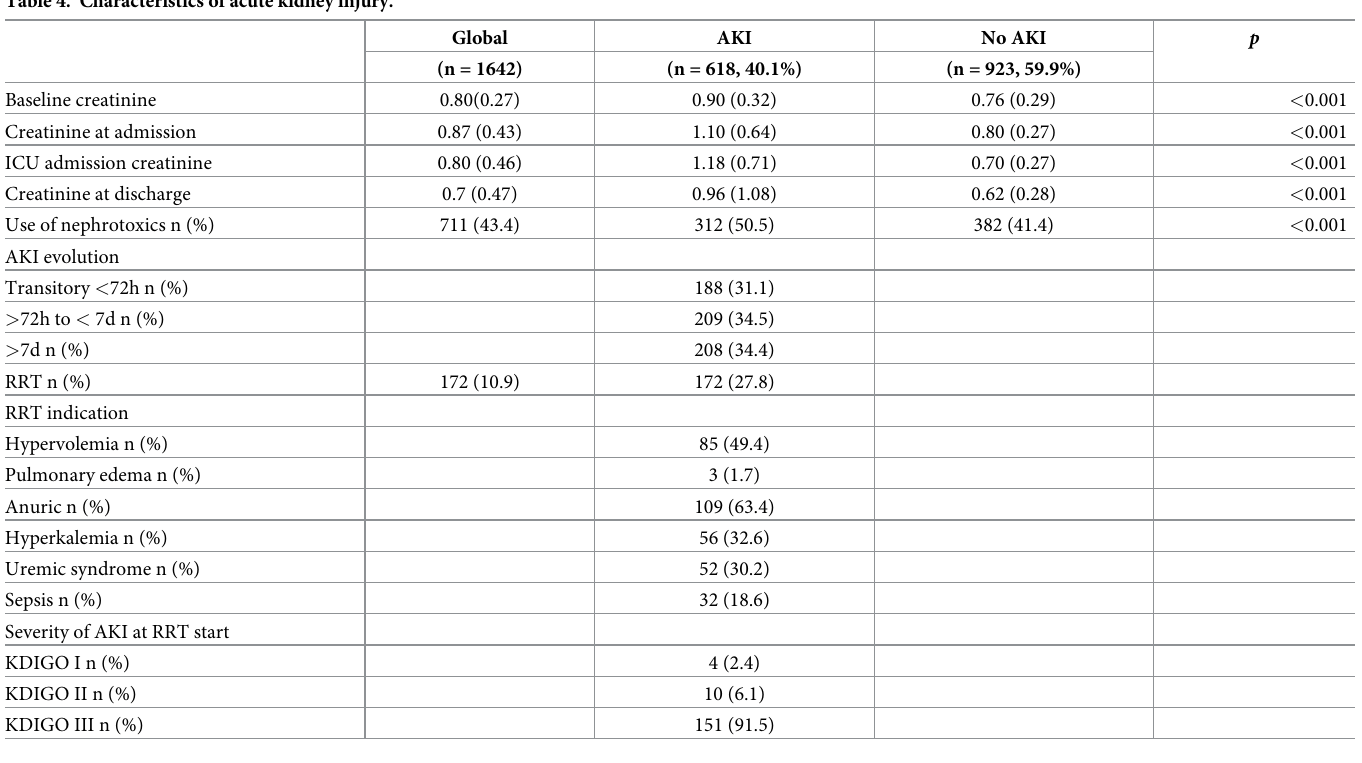
Table 4. Characteristics of acute kidney injury.